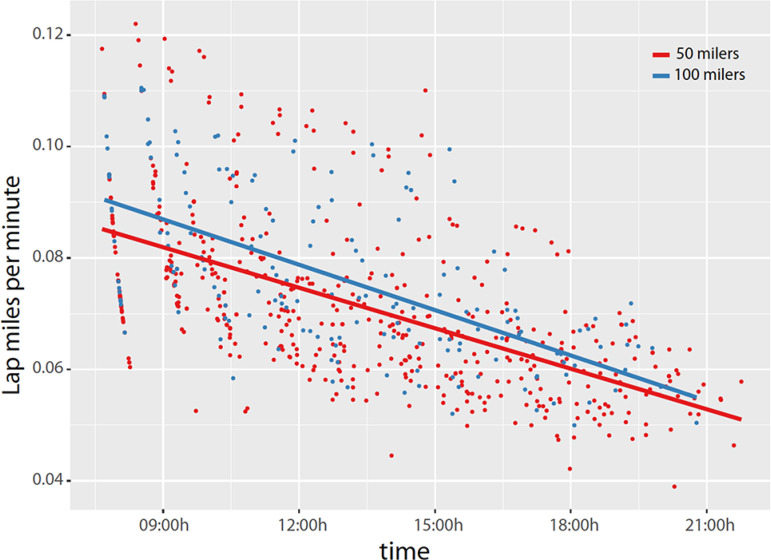
(A) Linear fit to account for the trending of a homeostatic influence: the slowing-down effect. All ultramarthoners slowed as time passed, and 100 milers (blue) were slightly faster compared to 50 milers (red).